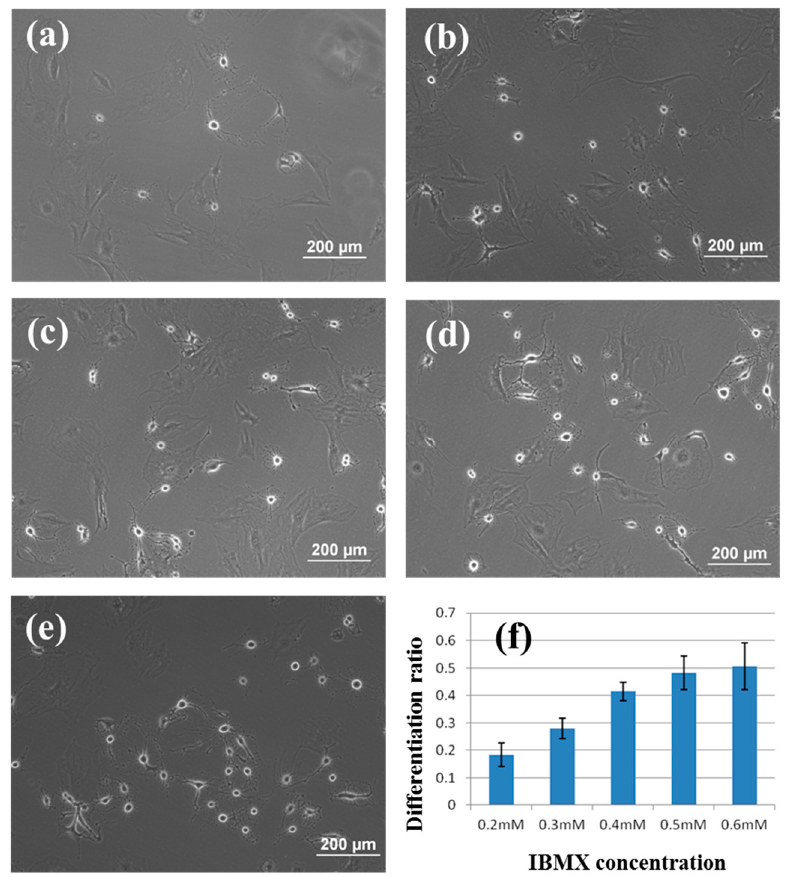
Figure 7. rBMSCs under ( a ) 0.2 mM, ( b ) 0.3 mM, ( c ) 0.4 mM, ( d ) 0.5 mM, and ( e ) 0.6 mM IBMX stimulation. ( f ) Neuronal cell differentiation ratio under various IBMX concentration. Y-axis indicates neuronal cell differentiation ratio and X-axis indicates the IBMX concentration (mM).